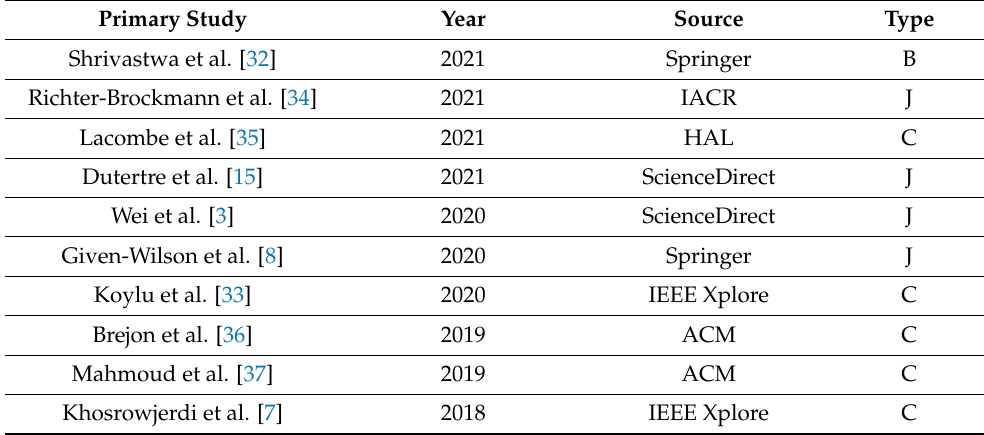
Table 1. Statistics of primary